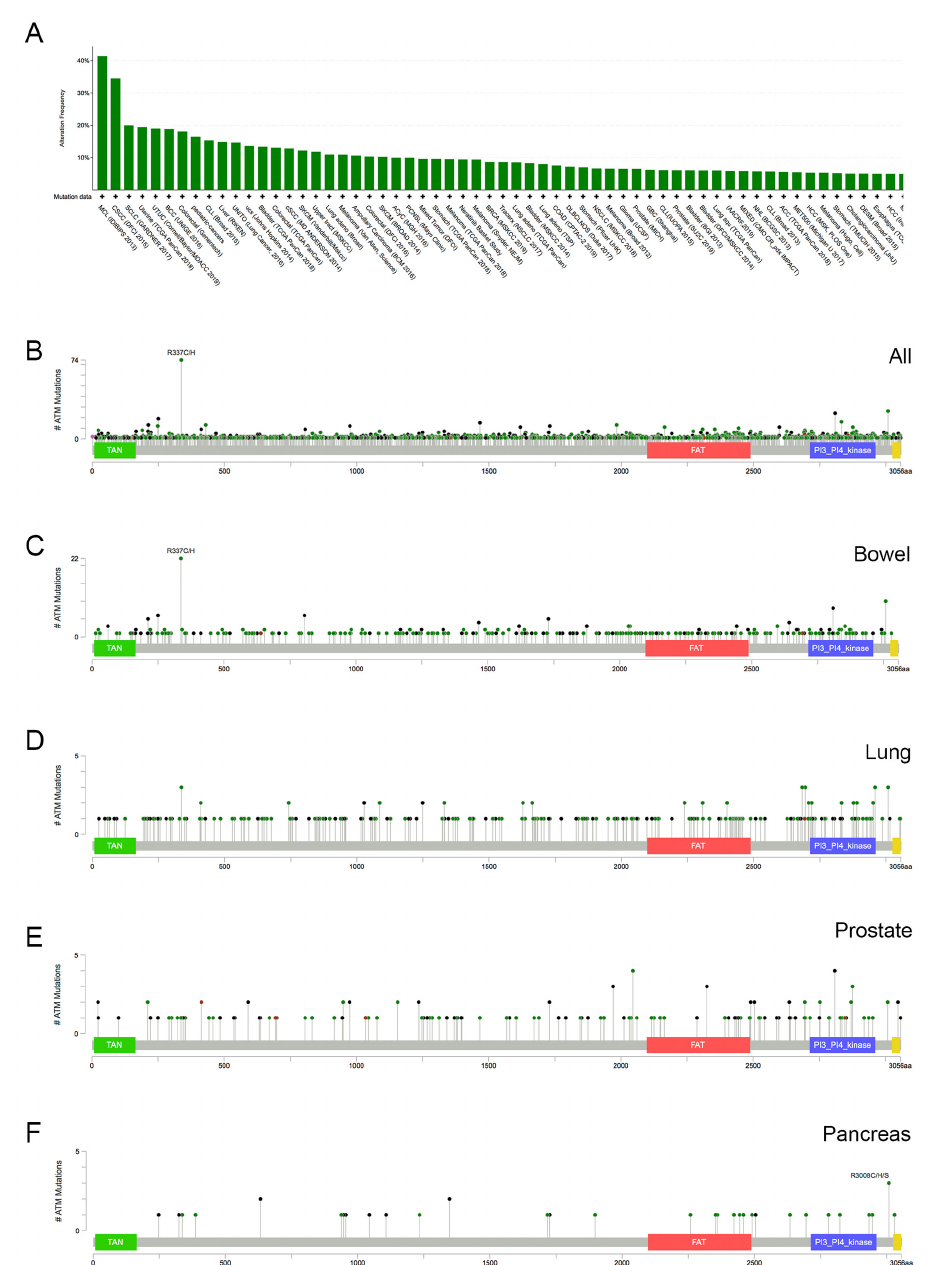
Figure 1. Frequency of Ataxia-Telangiectasia Mutated ( ATM) mutations in human cancer. ( A ) ATM was queried against all entries in the curated non-redundant data set on c-Bioportal (references [46,47]) accessed January 2020. Duplicate studies were removed and copy number variations are not included. The frequency of ATM alteration in various cancers is shown. ( B ) ATM is a 3056 amino acid protein consisting of a N-terminal TAN (telomere length maintenance and DNA damage repair) domain (residues 7–165), and a C-terminal kinase domain (residues 2714–2961) flanked by FAT (2097–2488) and FATC (3205–3055) domains. The location of mutations in ATM from all samples in the curated non-redundant data site available on c-Bioportal (references [46,47]), accessed January 2020 (duplicate sets removed and copy number variation not include) is shown. Mutations were distributed across the entire the coding region however, one mutation R337C / H was detected in 74 out of 2263 samples, across all cancers. ( C ) The R337C / H mutation was frequent in bowel cancer (22 out of 331 samples) but less so in lung (panel D ), prostate (panel E ) and pancreatic cancers (Panel F ).